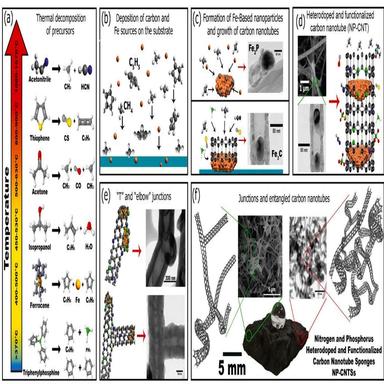
(a) Thermal decomposition of precursors used in the CVD synthesis. (b–d) Schematic representation of how the Fe-based nanoparticles grow from Fe coming from the thermal decomposition of ferrocene and how they catalyze carbon nanotubes. The phosphorus and nitrogen come from the thermal decomposition of triphenylphosphine and acetonitrile. The carbon monoxide and water from acetone and isopropanol thermal decomposition increase the pressure and avoid amorphous carbon formation. Additionally, alc